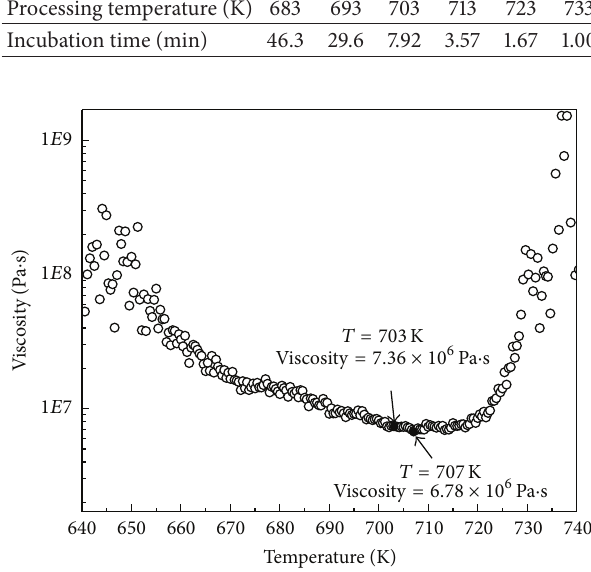
Figure 3: Newtonian viscosity of Zr 65 Cu 17.5 Ni 10 Al 7.5 BMG versus